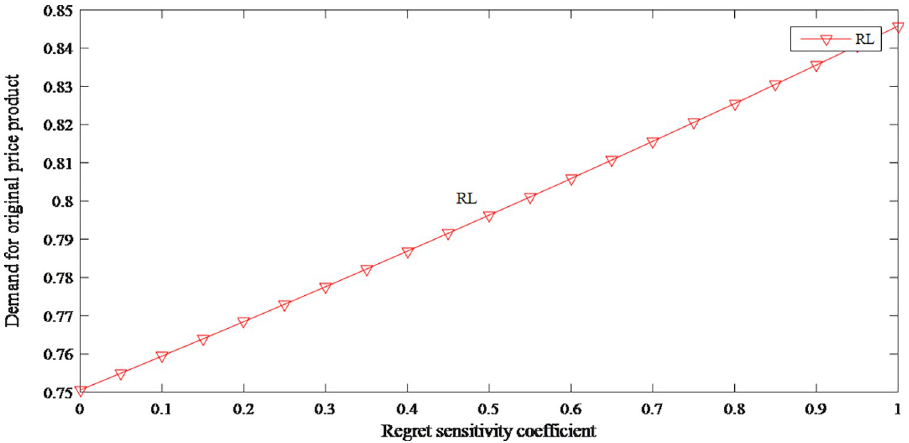
Fig 3. The impact of anticipated regret on demand for original price